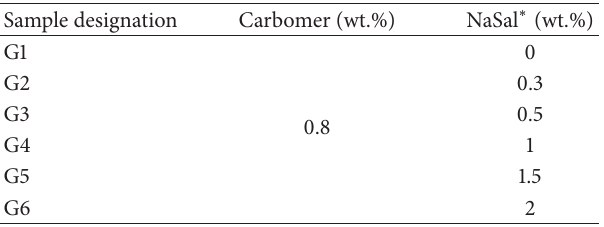
Table 1: Compositions of the investigated hydrogel